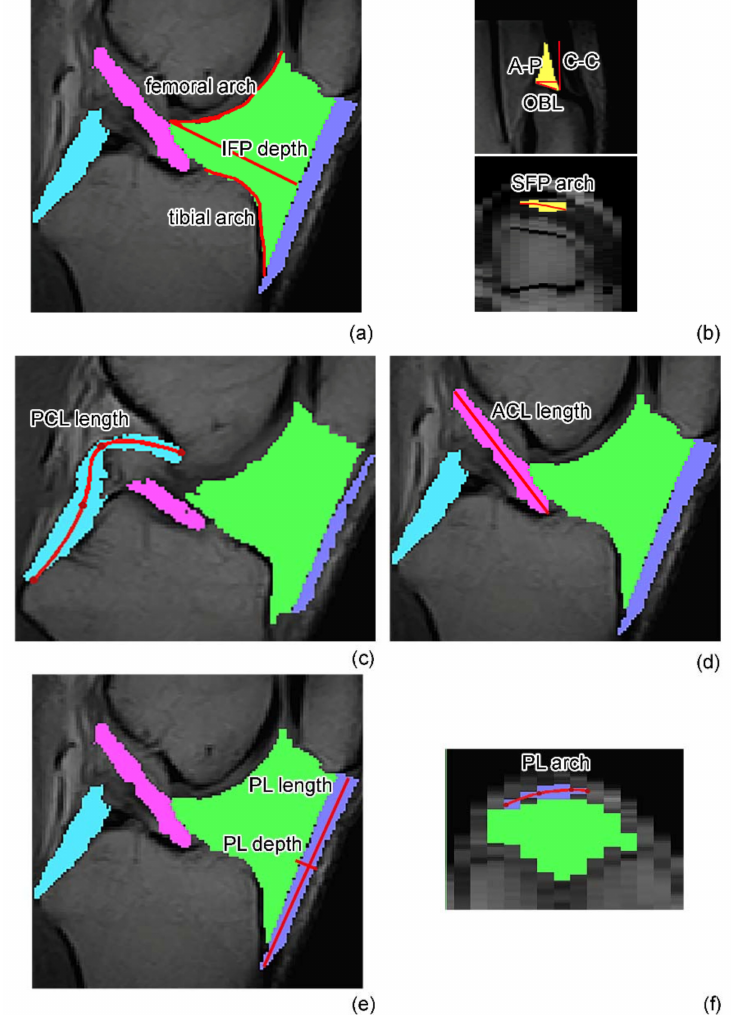
Figure 2. ( a ) Definition of IFP depth, femoral and tibial arch lengths in the central slice. ( b ) Definition of antero–posterior (A–P), cranio–caudal (C–C), and oblique (OBL) lengths for the SFP in the central slice, with the definition of SFP arch length on the transversal slice. ( c ) Definition of PCL and ( d ) ACL lengths on two different sagittal slices. ( e ) Definition of PL depth and length on the central sagittal slice and ( f ) PL arch length on the transversal slice. IFP: infrapatellar fat pad, SFP: suprapatellar fat pad, ACL: anterior cruciate ligament, PCL: posterior cruciate ligament, PL: patellar